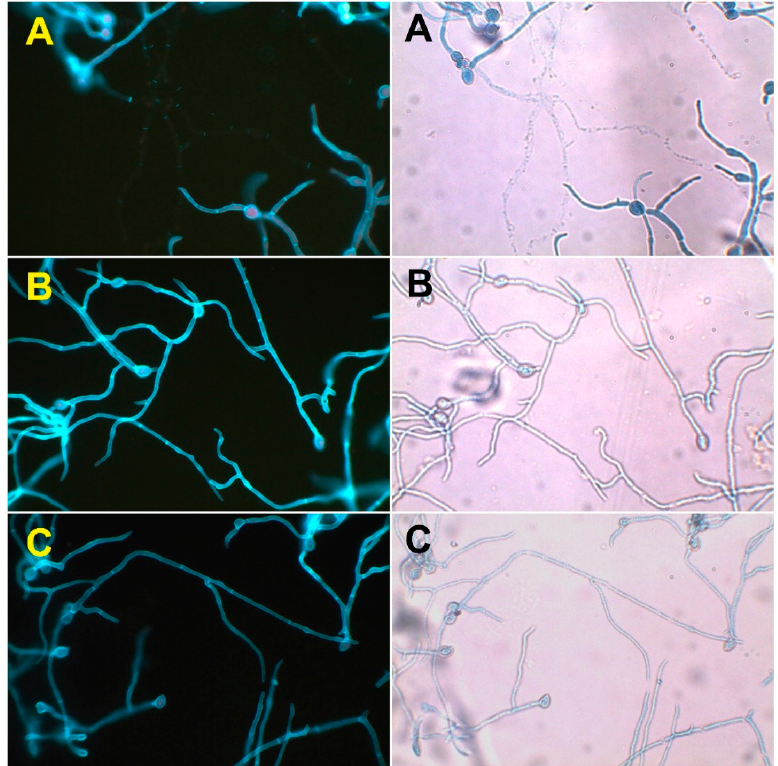
Figure 2. Effect of compound 3a on the cell wall of B. cinerea . Hyphae of B. cinerea incubated with liquid medium along with ( A ) lysing enzymes (positive control), ( B ) acetone 5% ( v / v ) (negative control), and ( C ) compound 3a at 0.16 mM. B. cinerea hyphae were treated with calcofluor white (CFW) stain. Assays were carried out in triplicate.